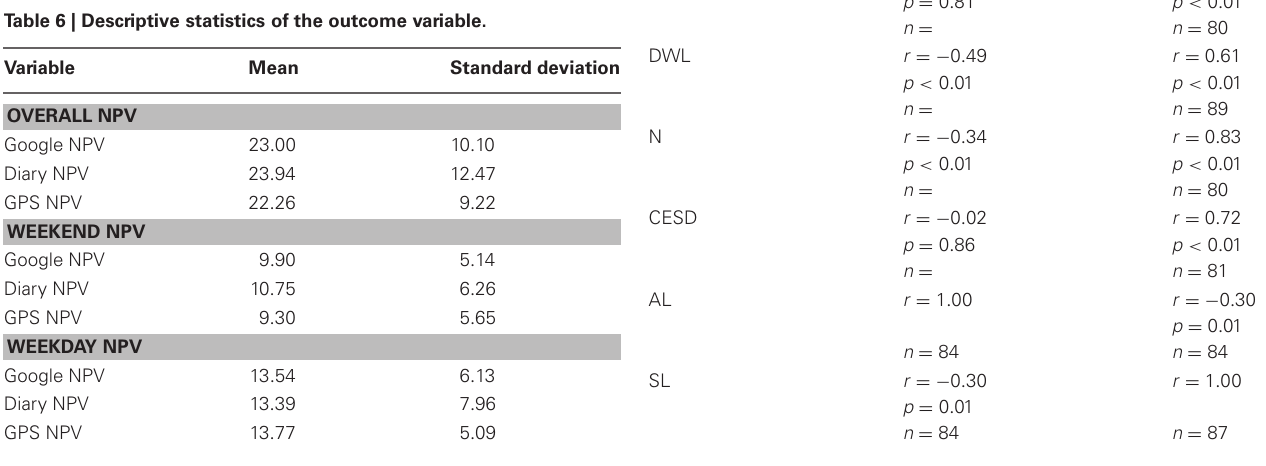
Table 6 | Descriptive statistics of the outcome